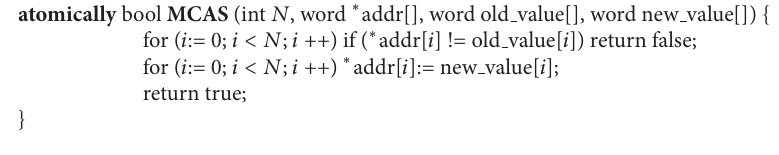
Algorithm 3: Abstract definition of multiword CAS